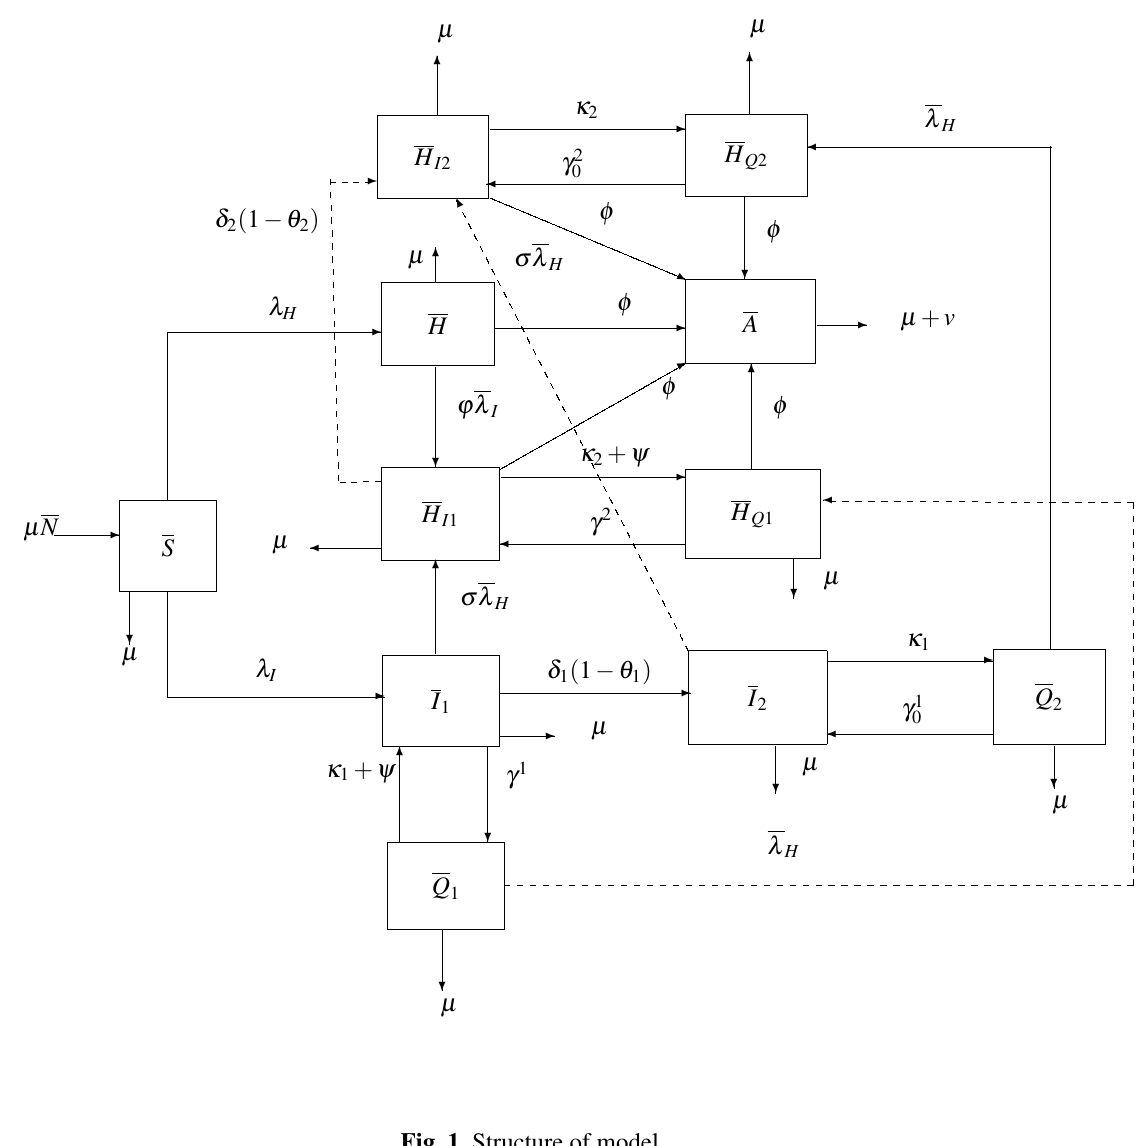
Fig. 1 Structure of